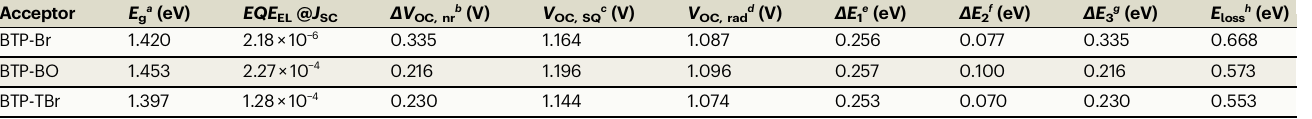
Table 2 | V OC and energy losses for xylene-processed solar cells based on PTzBI- d F